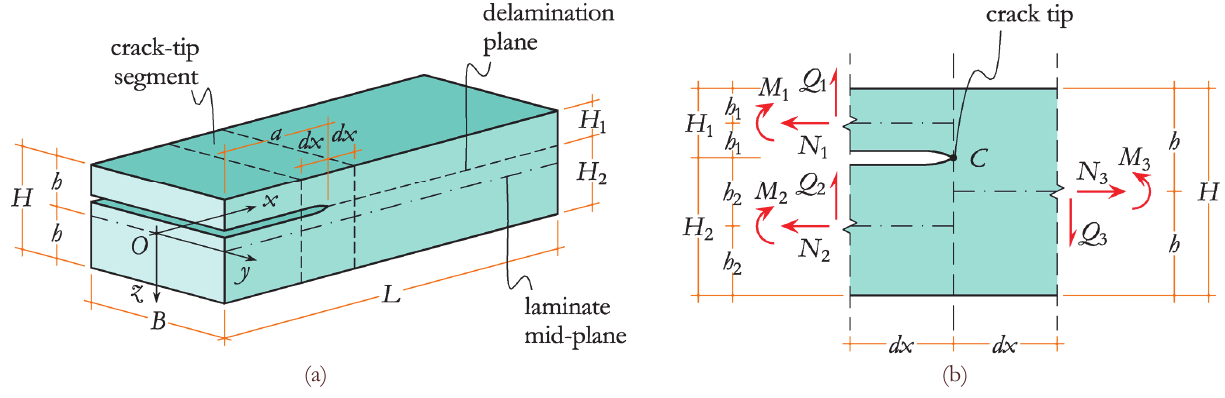
Figure 5: (a) General delaminated beam and (b) crack-tip